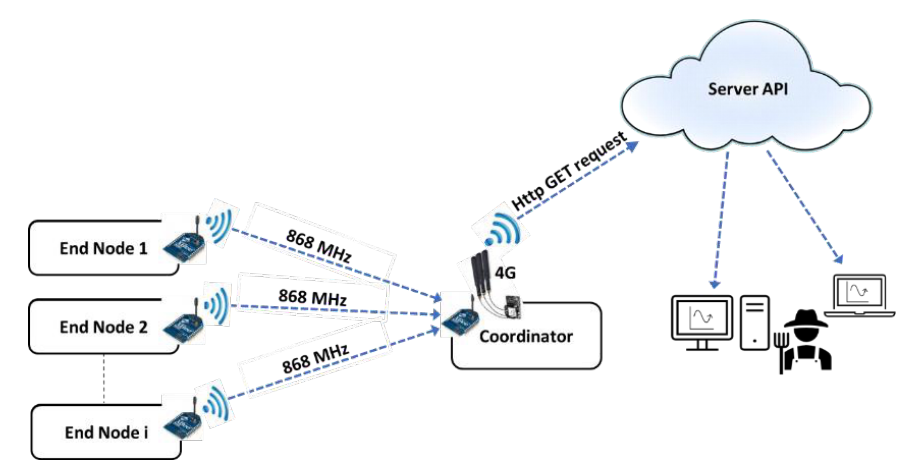
Figure 1. System topology and communication.